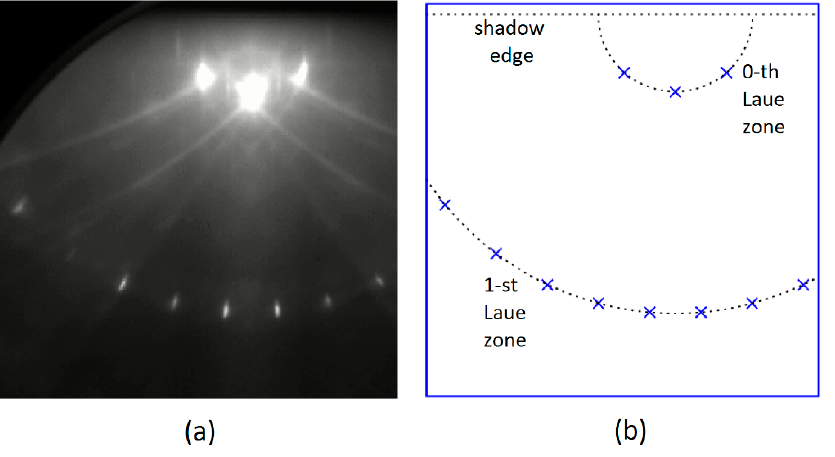
Figure 8. ( a ) Experimental RHEED pattern for a TiO2-terminated, SrTiO3(001) surface; ( b ) The pattern determined with the use of the Ewald geometrical construction.